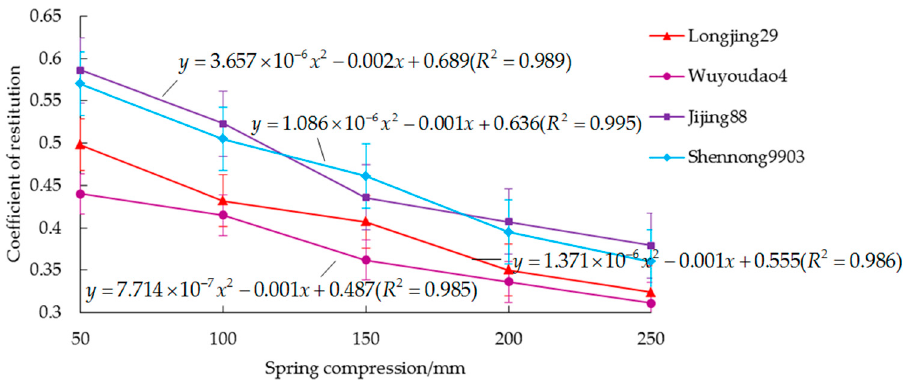
Figure 7. Effect of spring compression on restitution coefficient of rice grain. Note: In the test, the contact material was plexiglass plate, and the moisture content was 18.91%.